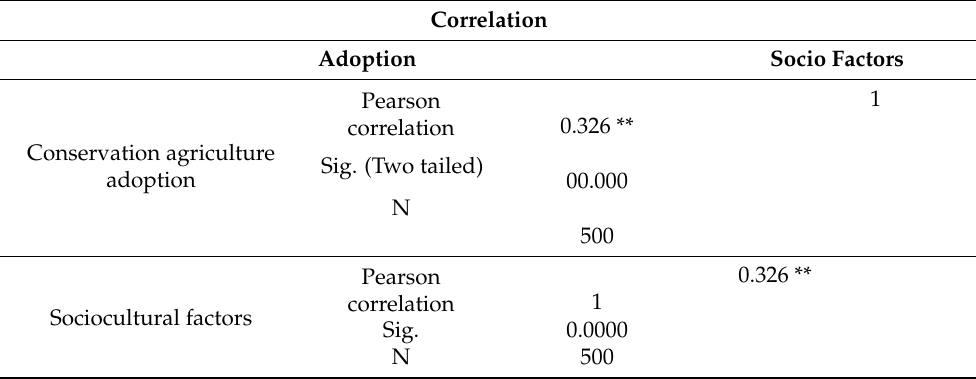
Table 4. Conservation agriculture adoption and social factors Pearson correlation